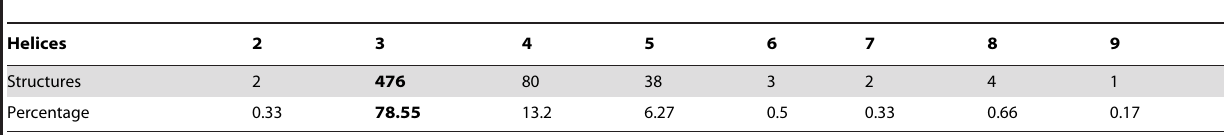
Table 1. Secondary structures of anaerobic fungal ITS1